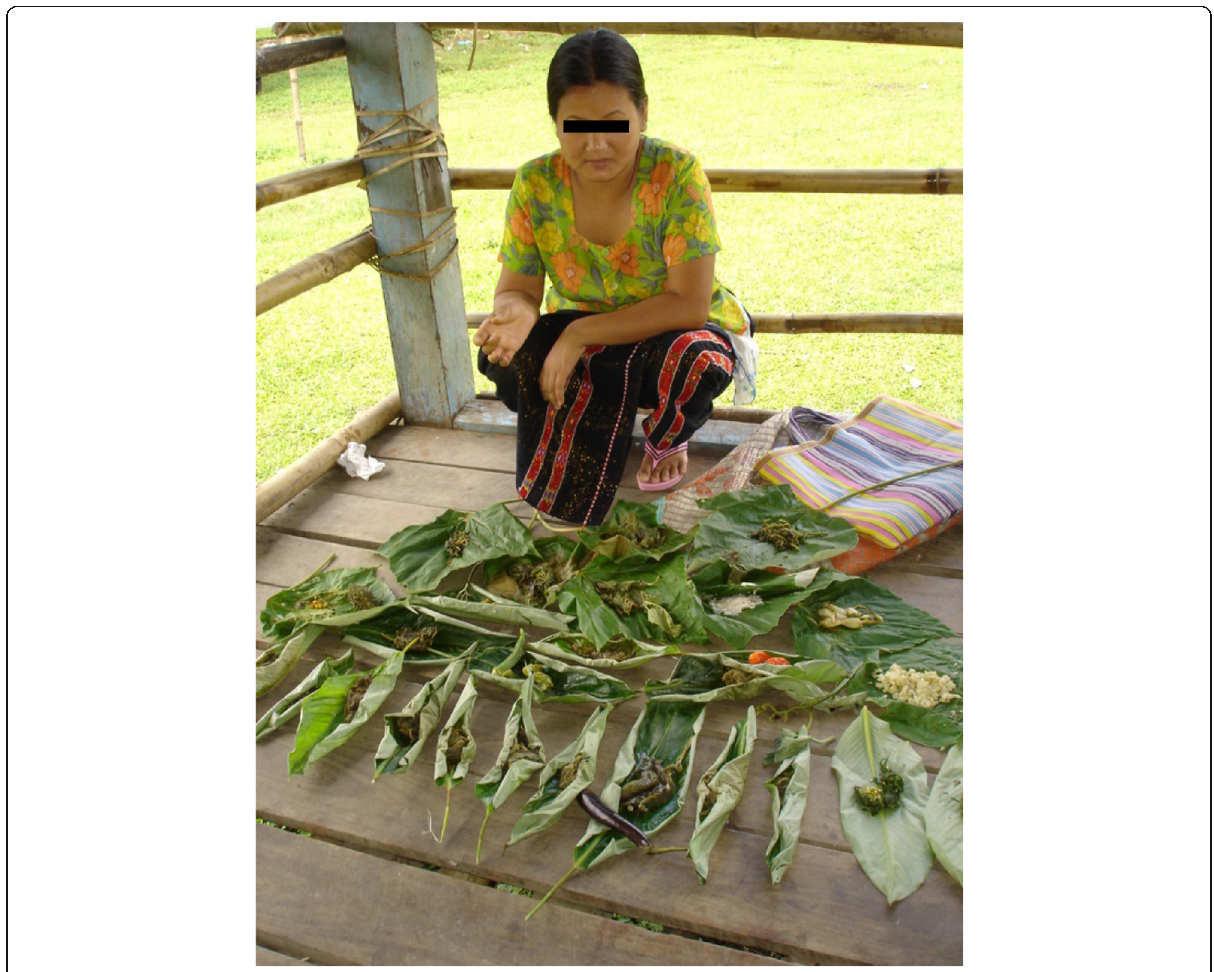
Fig. 3 An Adi woman displaying diversity of traditional food prepared from local plant and animal species (photo by Ranjay K.